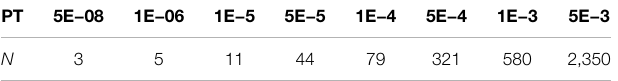
TABLE 1 | Number of SNPs selected on different p -value thresholds